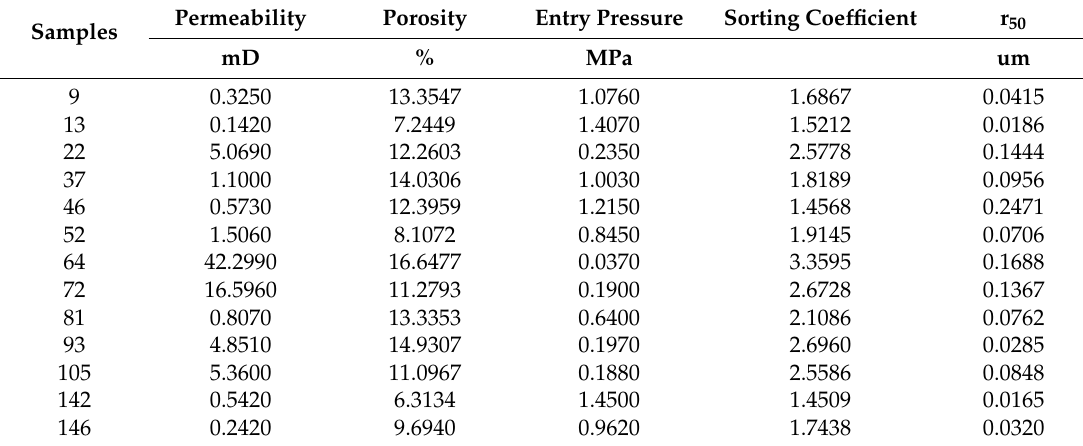
Table 1. Parameters of the pore throat structure obtained from the 13 samples.